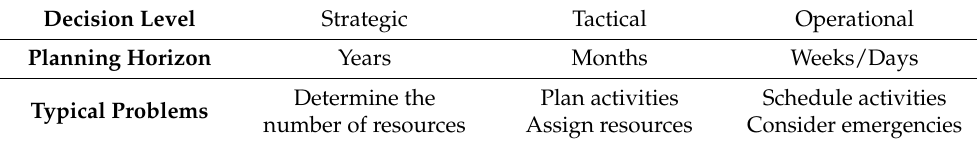
Table 1. Levels of